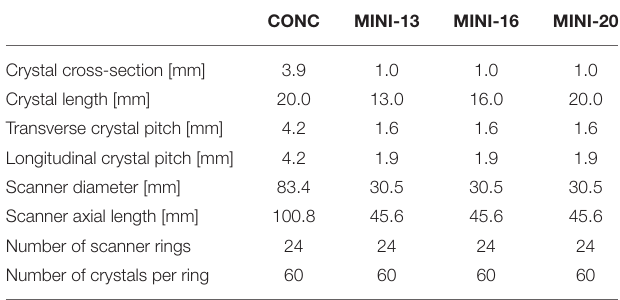
TABLE 1 | Geometrical features of the conceptual and miniaturized